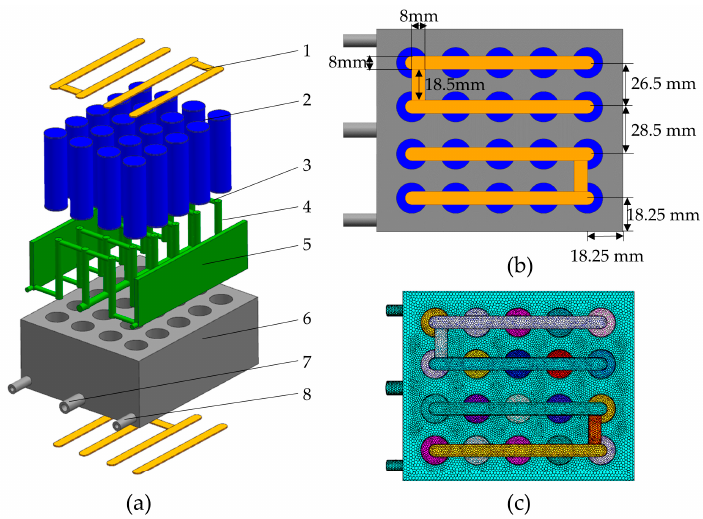
Figure 2. An illustration of the new liquid-cooled shell battery module: ( a ) overall structure of battery module system with both positive and negative connections (yellow color); ( b ) top view of the battery module with positive terminal connection; ( c ) grid model. 1-busbar, 2-cell, 3-lateral channel, 4-longitudinal channel, 5-liquid channel, 6-shell, 7-inlet, 8-outlet.